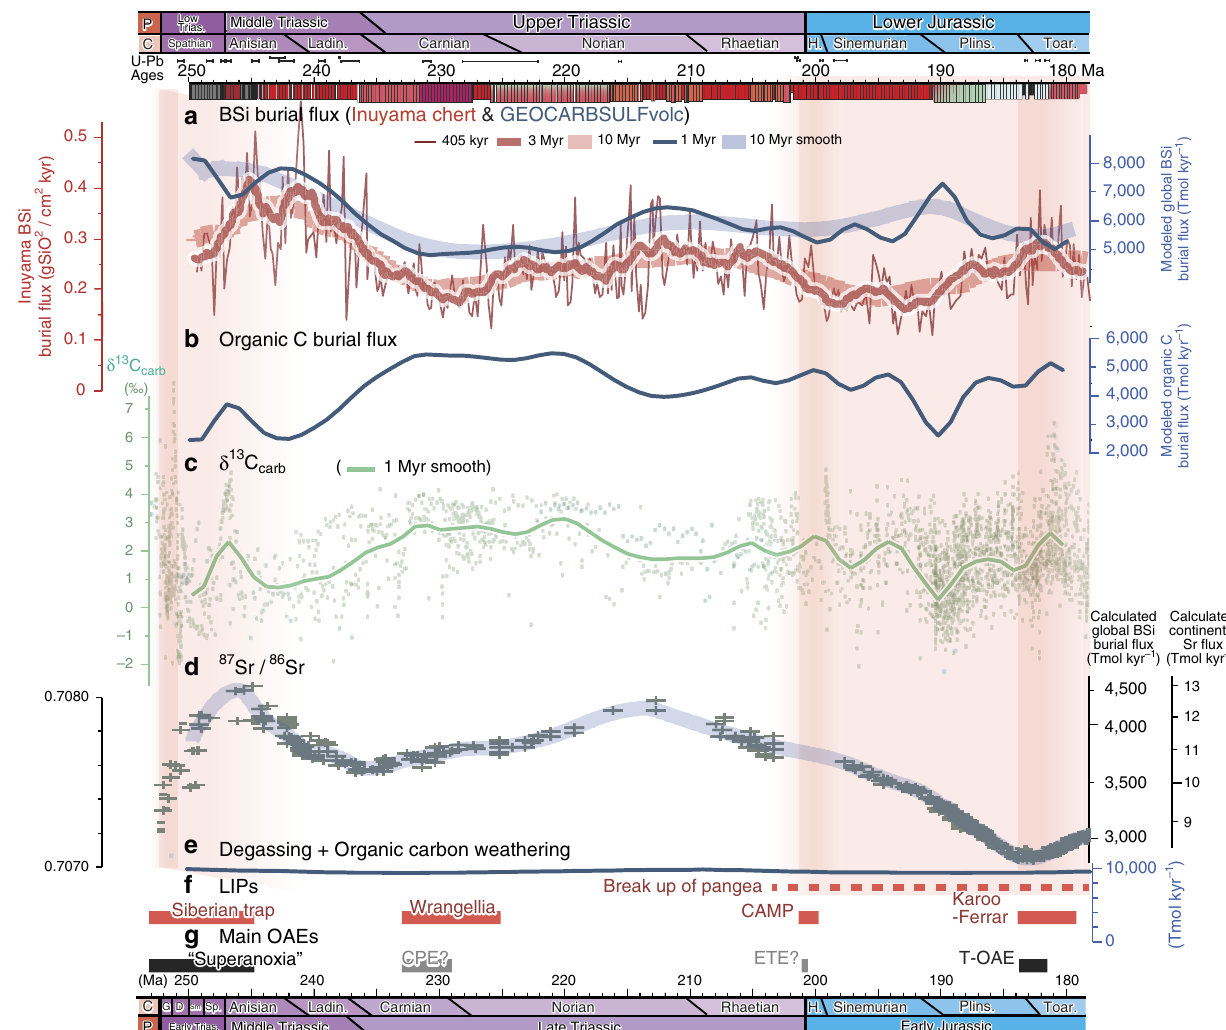
Figure 4 | Comparison of BSi burial flux of cherts with GEOCARBSULFvolc model. Temporal variations in a BSi burial flux estimated from Inuyama bedded chert and modified GEOCARBSULFvolc, ( b ) organic carbon burial flux estimated from modified GEOCARBSULFvolc, ( c ) carbonate carbon isotope and ( d ) 87 Sr/ 86 Sr isotope record of seawater between 250 and 180Ma 16 . Y axes on the right side of d are the calculated continental Sr flux and corresponding BSi burial flux (see Methods). Three Myr and 10My smoothing window for BSi burial flux of Inuyama chert were chosen taking into account of the residence time of Sr in the ocean and the smoothing time step of GEOCARBSULFvolc 14,15 . ( e ) A combined flux of CO 2 degassing and organic carbon weathering calculated from GEOCARBSULFvolc. Periods of ( f ) LIPs and ( g ) Main oceanic anoxic events (OAEs) are also shown. Possible regional OAEs associate with massive sponge deposition during CPE and ETE are shown in grey colour. Age model is revised according to Geologic Time Scale 2012 (ref. 65) and Ikeda and Tada 13 . The orange shade areas represent the periods of high hydrothermal flux intervals with higher probability on darker colour 52,67,68